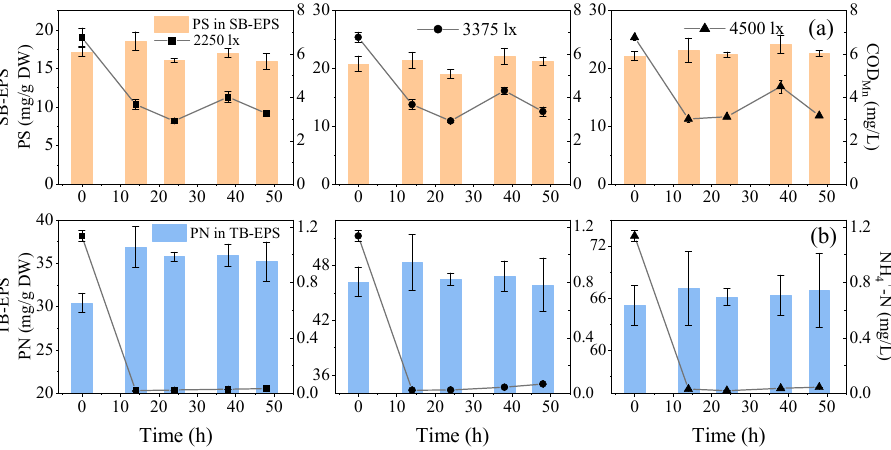
Figure 4. The variation of EPS components responding to COD Mn and NH 4+ -N concentration under different light intensities: ( a ) the changes of COD Mn and carbohydrate (PS) in SB-EPS, ( b ) NH 4+ -N and protein in total-EPS in the pretreatment process.